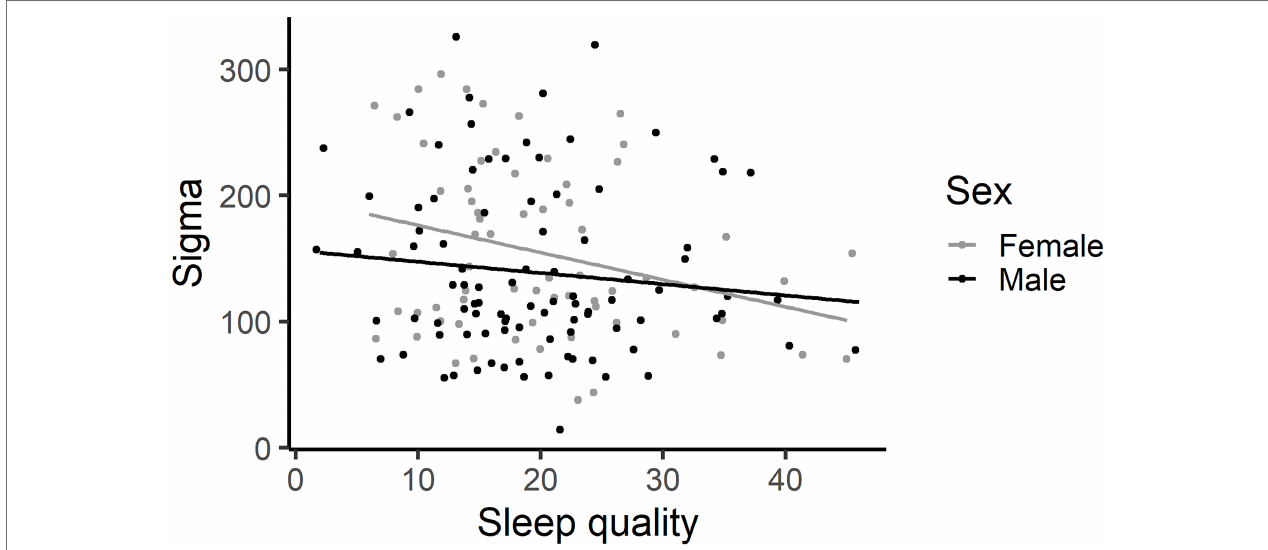
FIGURE 8 | The higher the score on the sleep quality scale, the worse the child’s sleep. The worse a child’s sleep, the less variably the child responded. This graph has each individual’s data point shown, using